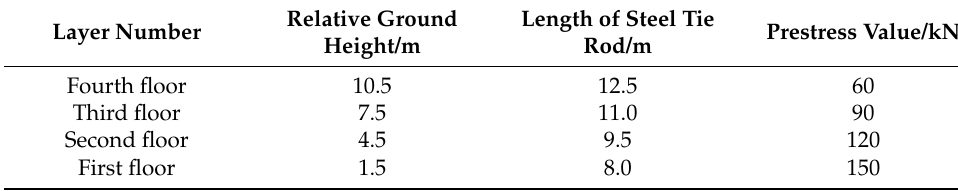
Table 2. Parameters of anchor-plate of example 1.